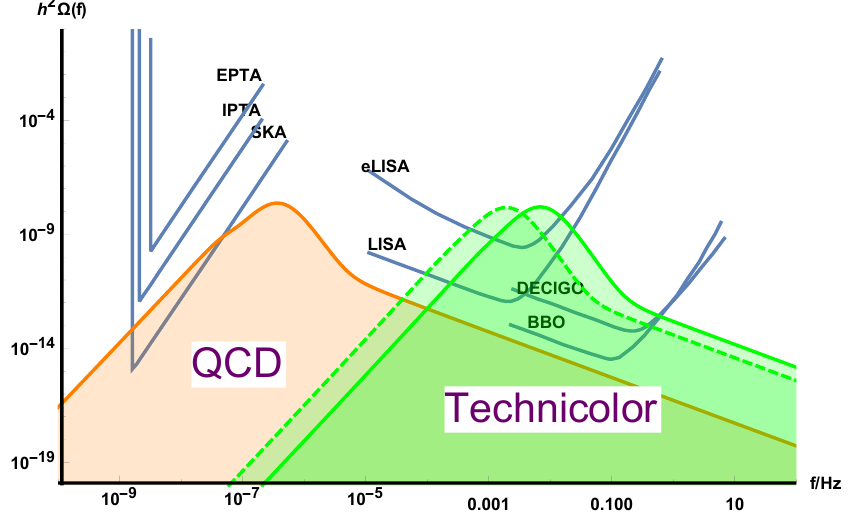
Figure 6 . The combined GWs spectra from QCD and EW phase transitions and compare with possible GWs